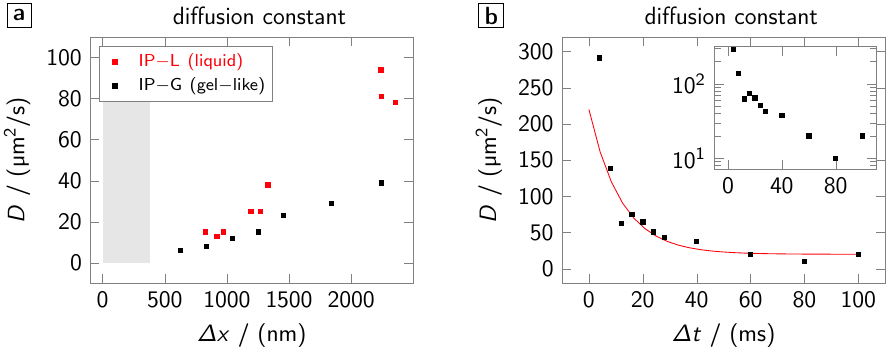
Figure 6. Effective diffusion constant determined from the fits. ( a ) Dependence of the constant on the line separation in IP-L and IP-G. The grey area indicates the spatial extent (full-width-half-maximum) of the excitation focus; and ( b ) dependence of the constant on the time delay in IP-G. The red line is an exponential fit to the data excluding the values at 4 ms and 100 ms. The inset shows a log-plot of the